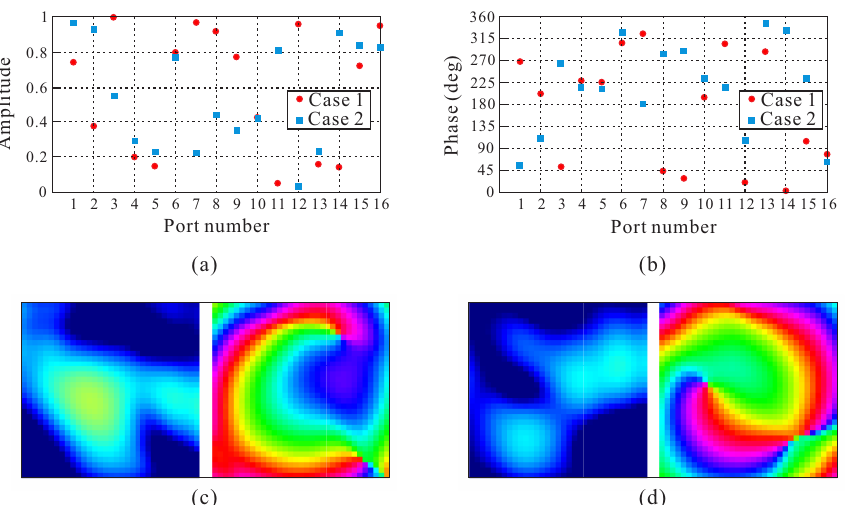
Figure 5. Examples of near-field data based on random excited signal: ( a ) excitation amplitude of ports for cases 1 and 2, ( b ) excitation phase of ports for cases 1 and 2, ( c ) near-field distribution in case 1, and ( d ) near-field distribution in case 2.